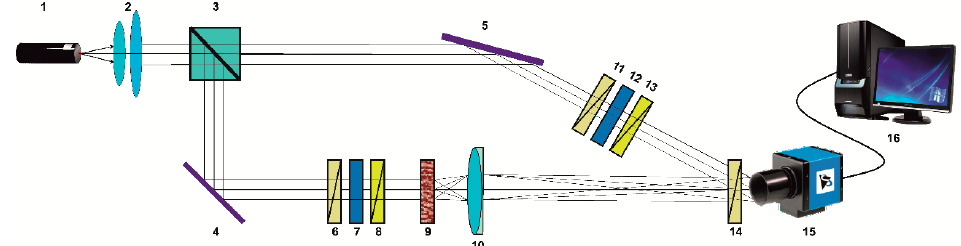
Figure 1. Schematic presentation of experimental set-up of 3D Muller matrix tomography of biological layers. Here: 1—He-Ne laser; 2—collimator; 3—beam splitter; 4; 5—optical mirrors; 6; 8; 11; 13; 14—polarizers; 7; 12—quarter wave plates; 9—object of study; 10—strain-free microobjective; 15—digital camera; and 16—personal computer (PC) workstation. The image of the object nine has been obtained using lens 10 (Nikon CFI Achromat P, focal length 30 mm, numerical aperture 0.1, and magnification 4 × ) and photosensitive pad ( m × n = 1280 × 960 pixels) of the digital camera